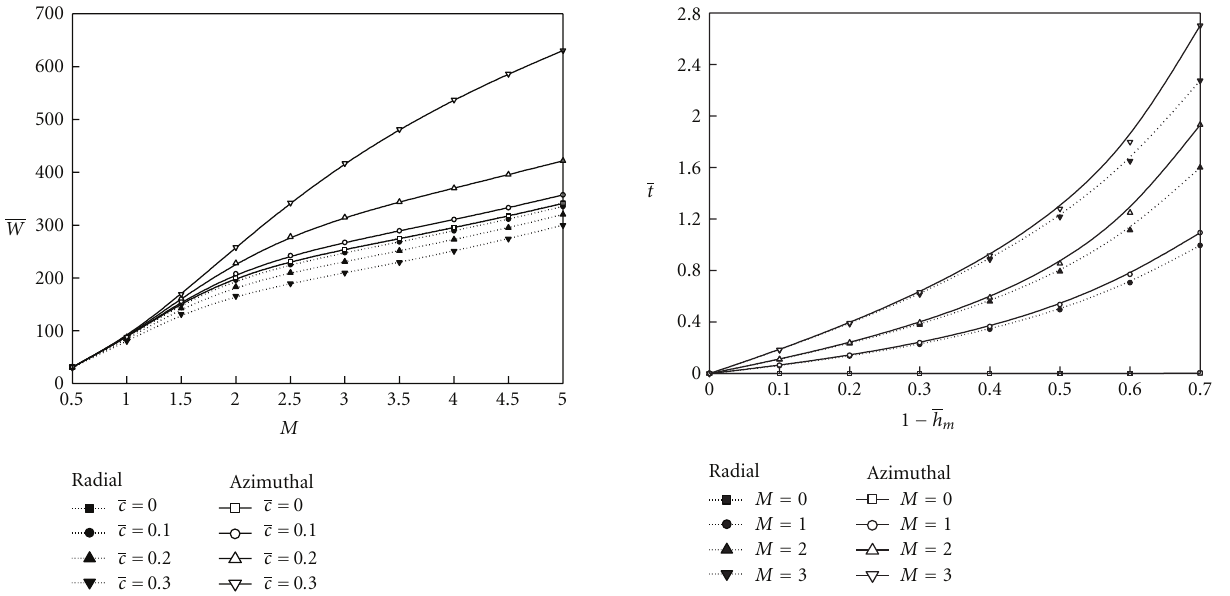
Figure 8: Variation of nondimensional mean load-carrying capac- ity W with M for di ff erent values of c with β = 0 . 05, l = 0 . 3, and ψ = 0 . 01.